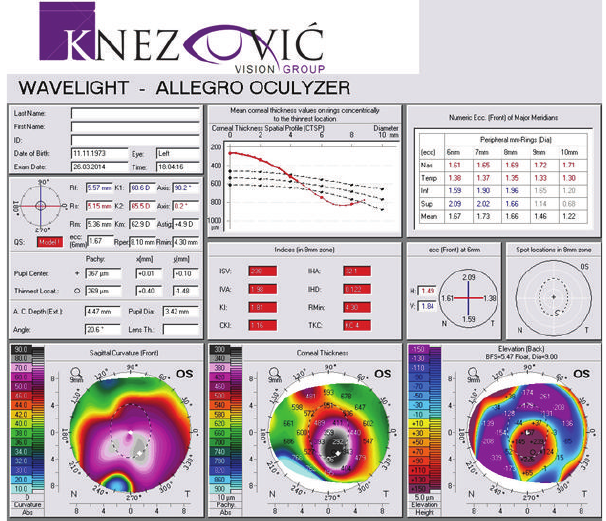
Figure 7: PCAM first examination, left eye.